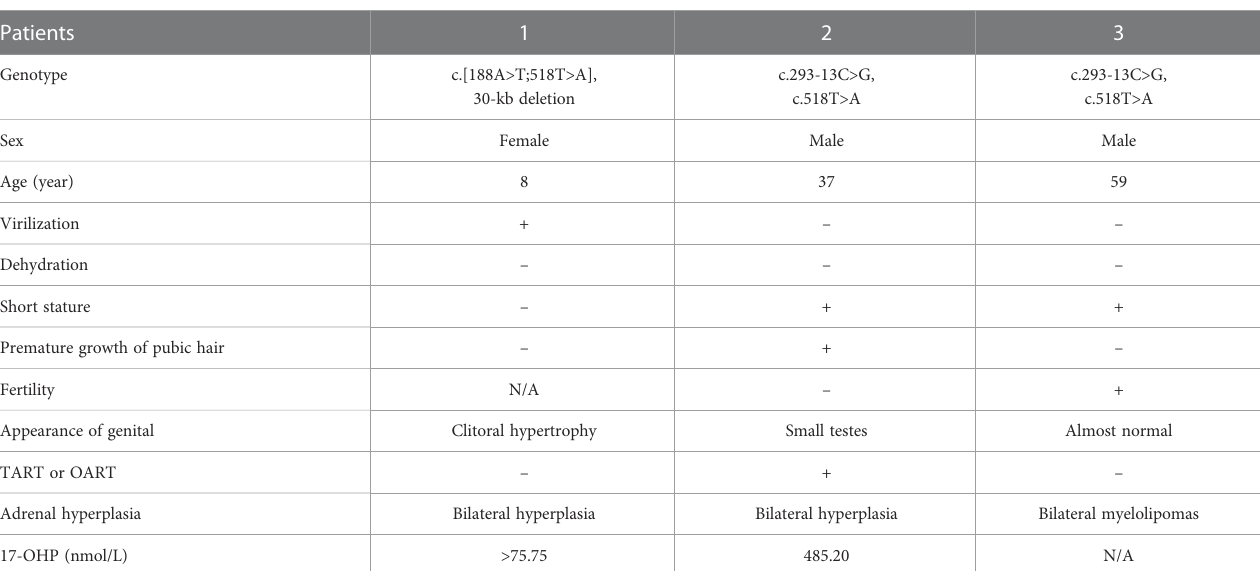
TABLE 2 The genotype-phenotype of the probands.